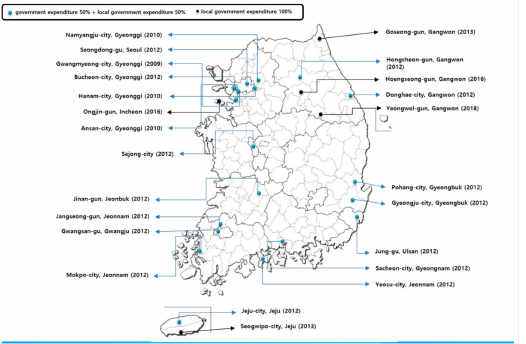
Figure 1. Current operation status of registration and education center for hypertension and diabetes in Korea. Years in parenthesis indicate the beginning time of the